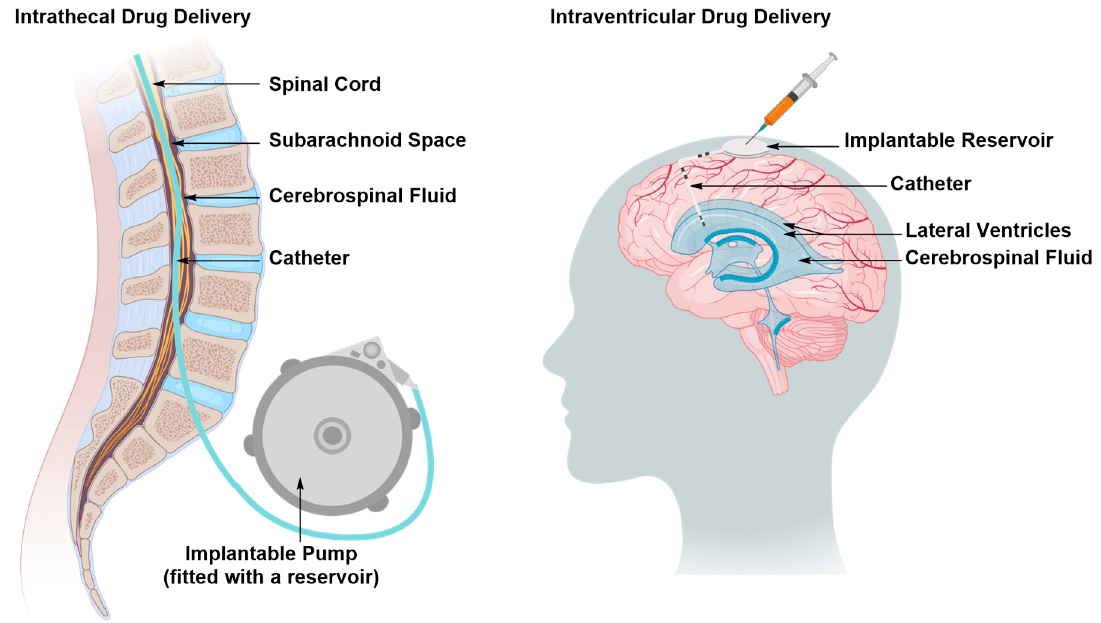
Figure 4. Direct delivery of the therapeutic material to the central nervous system (CSF) in the subarachnoid space of the spinal canal (intrathecal delivery) or brain ventricles (ventricular delivery) as time-separated boluses via an implantable reservoir. The injected therapeutic material traverses the CSF, accessing different regions of the CNS. The reservoirs are toped up by pump replacement or direct injection.